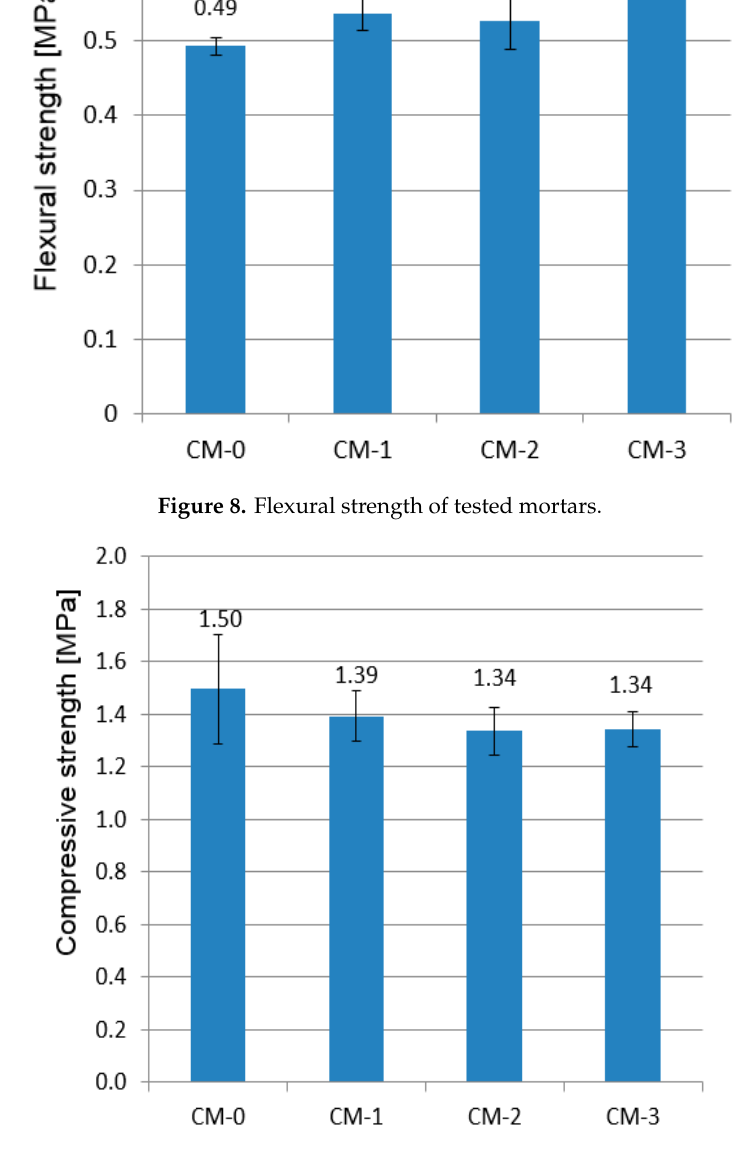
Figure 9. Compressive strength of tested mortars.